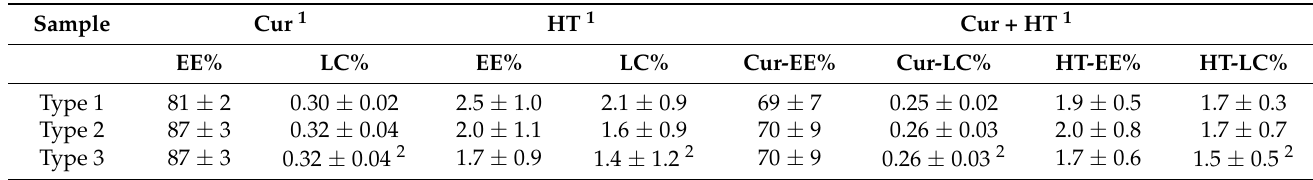
Table 2. EE% and LC% values of Cur and HT into liposomes (Types